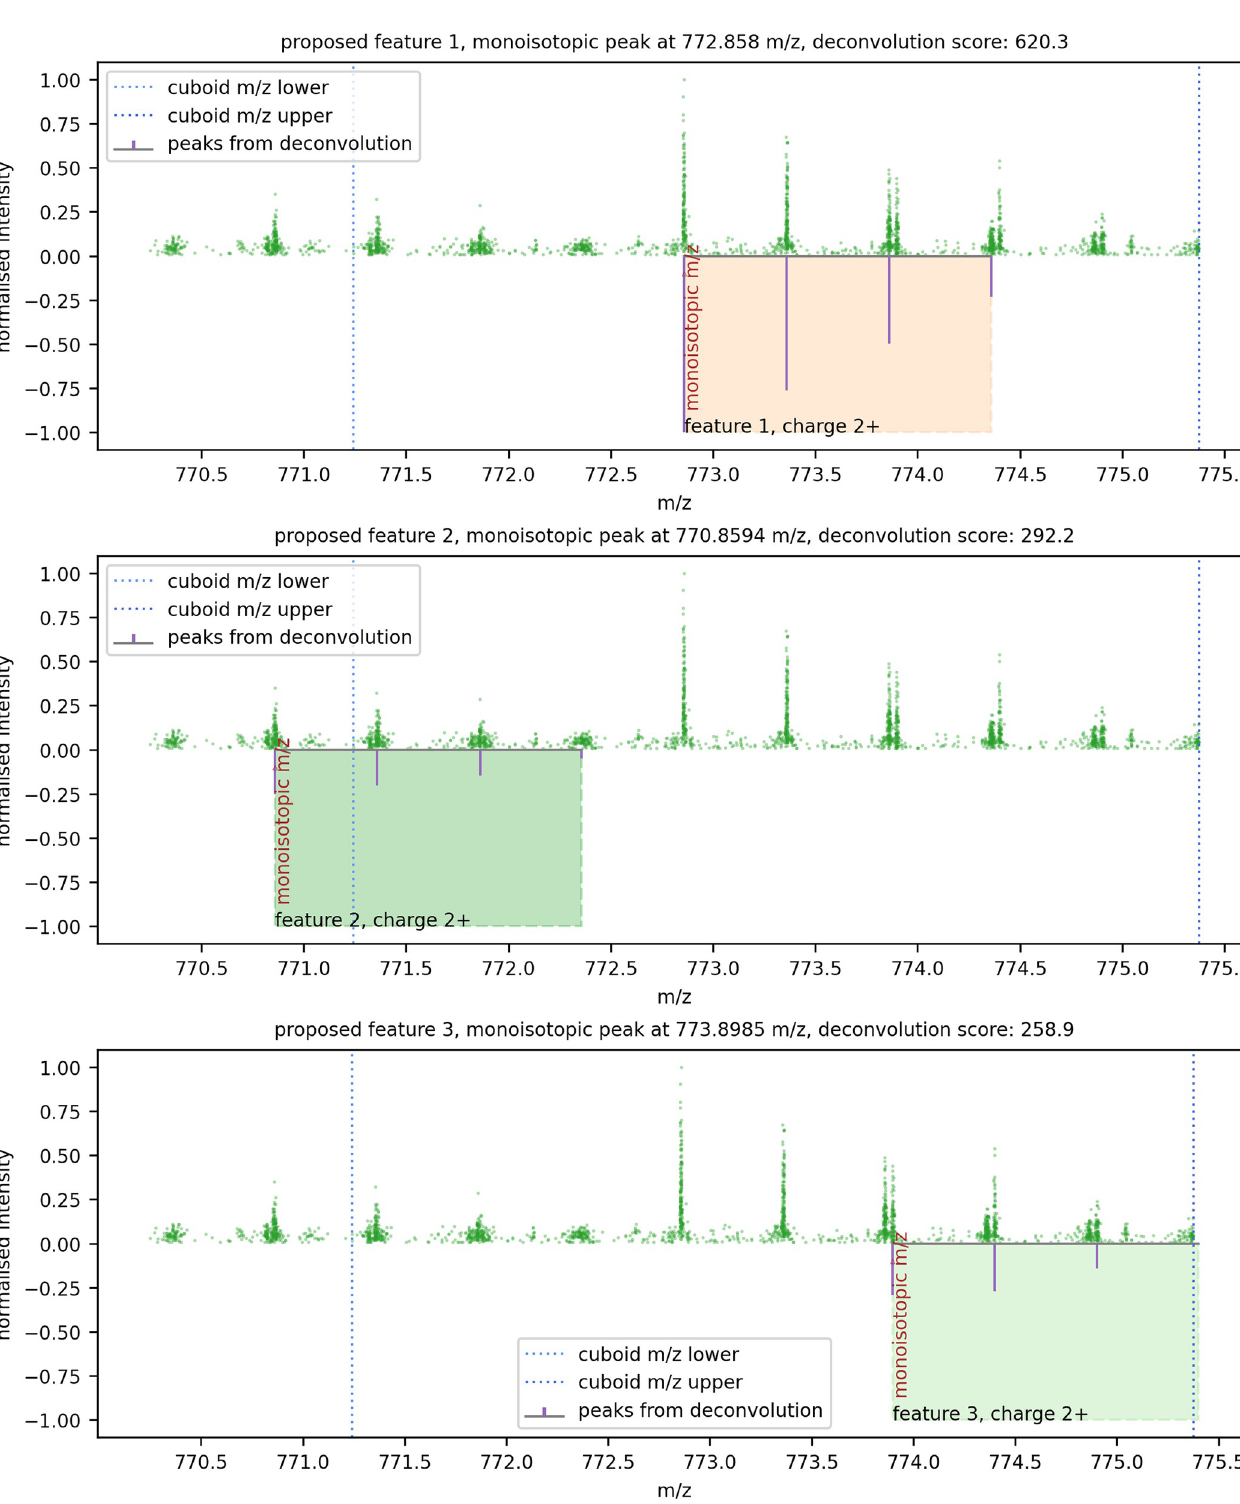
PLOS ONE | https://doi.org/10.1371/journal.pone.0271025 July 7,